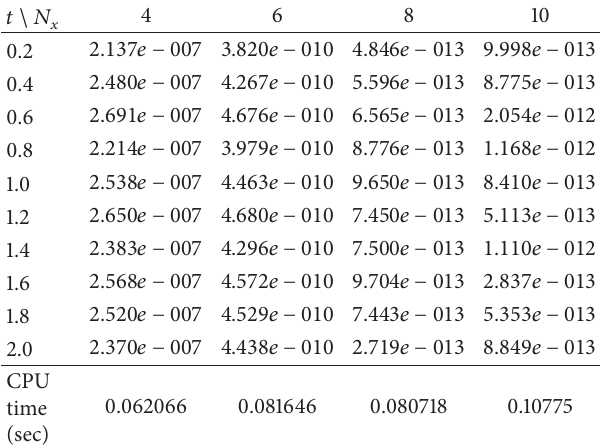
Table 11: Maximum errors 𝐸 𝑁 for the modified KdV-Burgers equation, with 𝑁 𝑡 = 10 .